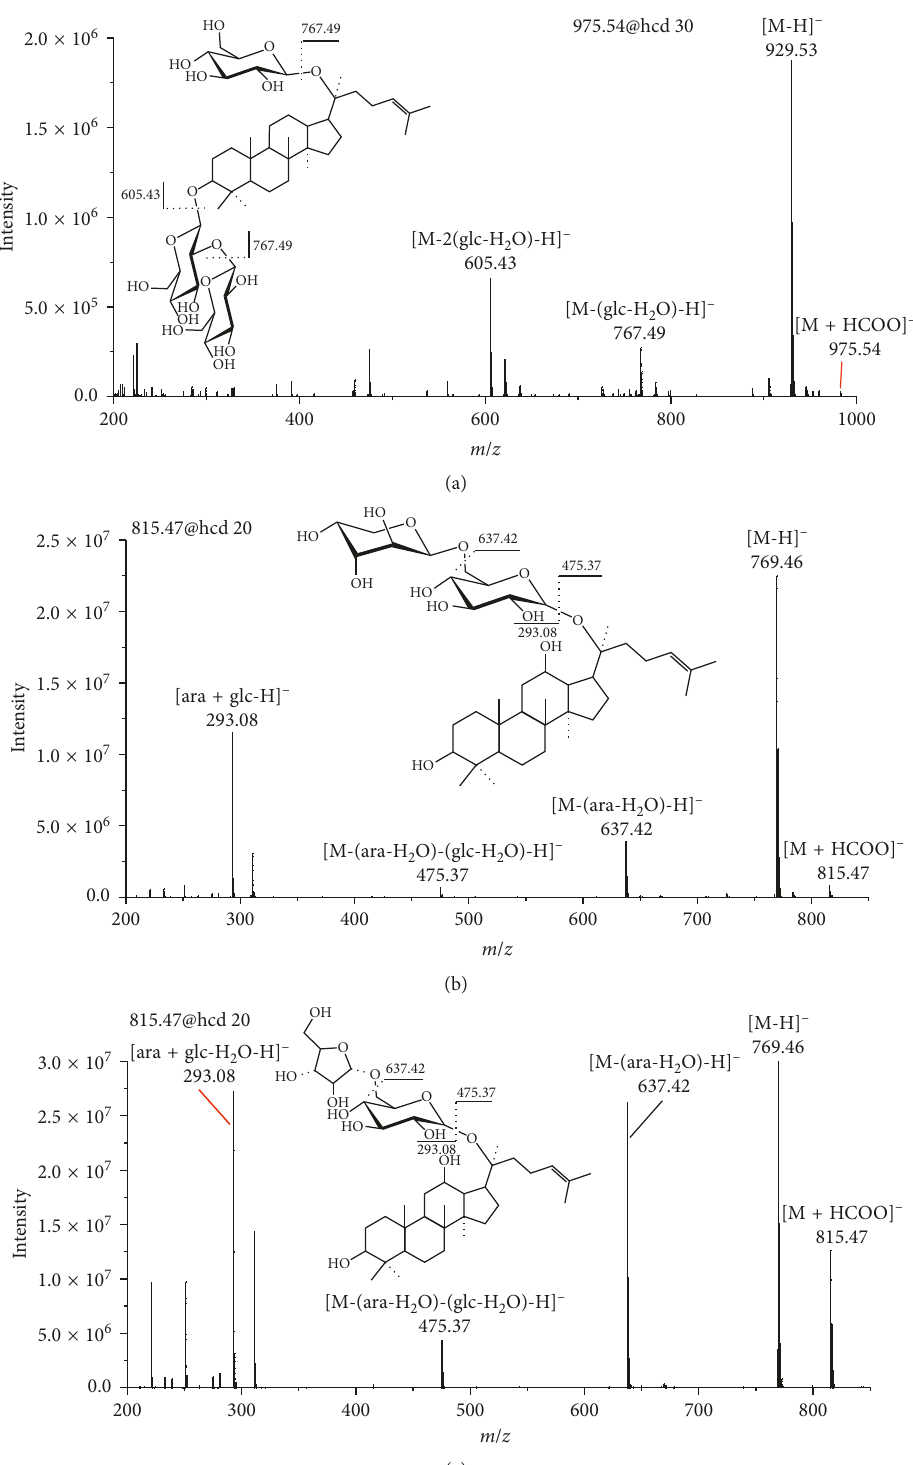
Figure 5: MS 2 spectra of [M +HCOO] for (a) Vina-ginsenoside R3, (b) ginsenoside F3, and (c) ginsenoside F5 in the negative mode. (The glc represent glucose and the ara represent −